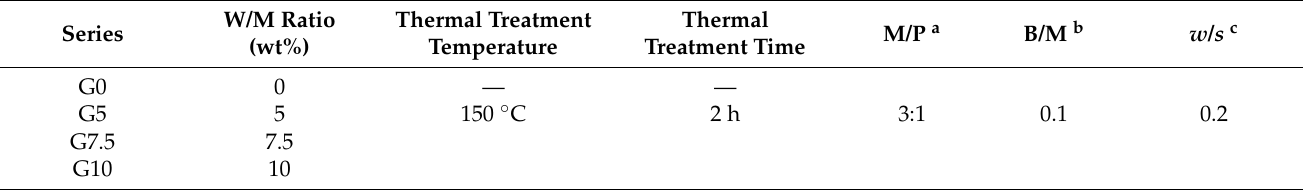
Table 2. Raw material modification and sample mix